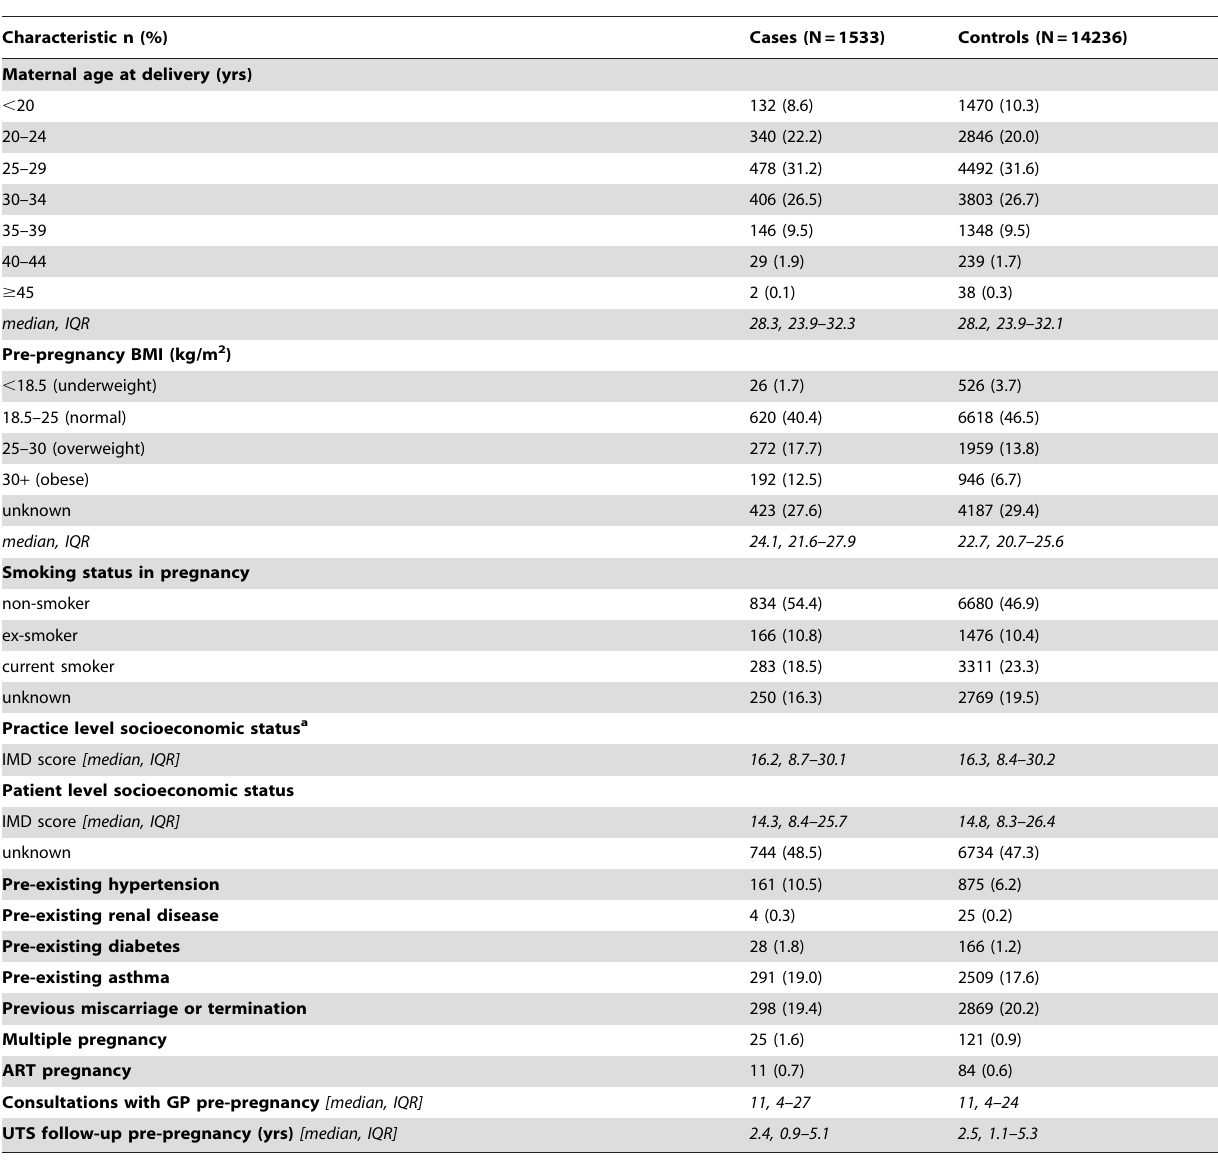
Table 1. Characteristics of study